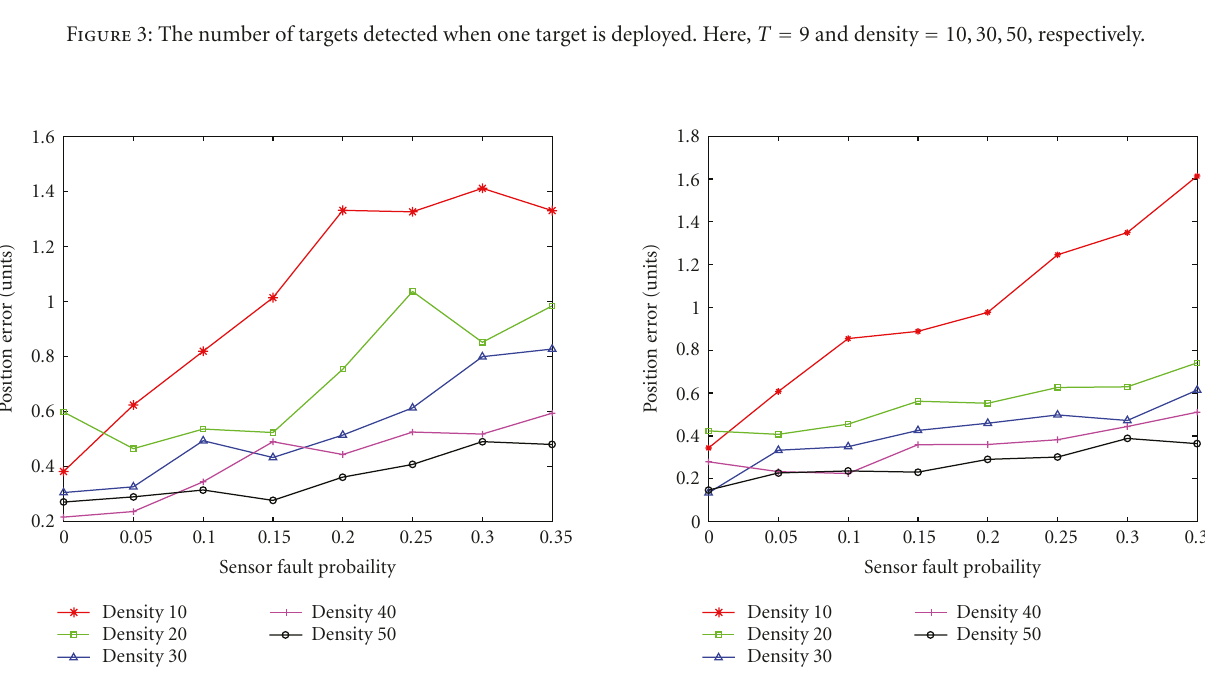
Figure 4: Position error versus p with di ff erent network densities when three targets are deployed. In this scenario, T = 1.